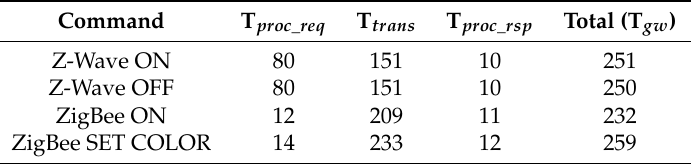
Figure 7. The runtime for executing one command from the user application. Table 4. Time (Millisecond) for Executing a Command in Gateway.